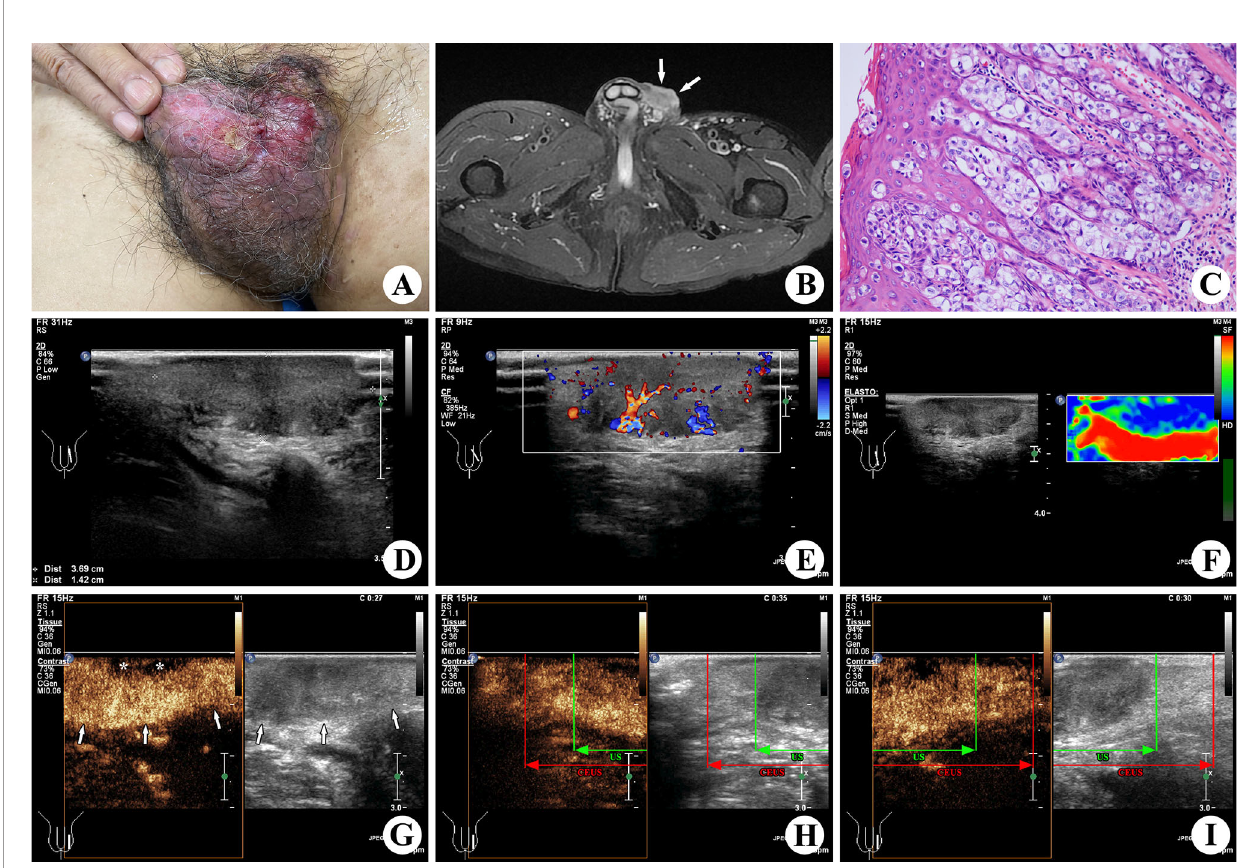
FIGURE 1 | A 67-year-old patient with EMPD. An ulcerative and eczematous lesion was shown on his left scrotum (A) . A lesion with irregular margin ( ↑ ) was found at his left scrotum in T2WI fat-suppressed sequences of MR (B) . Scattered epidermal Paget cells with a pleomorphic and hyperchromatic nucleus and abundant clear cytoplasm were located throughout the epidermis in nest-like structures in histopathologic examination of the excised specimen (×200; H&E stain) (C) . In the preoperative conventional US, a 3.6 × 2.9 × 1.4 cm lesion on the left side scrotal wall appeared to be hypoechogenicity, in fi ltrative margin, and presence of profuse vascularity (D, E) . Elastography showed blue color in and around the lesion, which was valued to be hard in a score of 4 (F) . The preoperative CEUS showed hyper- enhancement ( ↑ ) in the main part and non-enhancement (*) in the super fi cial area of the lesion (G) , which was larger than that shown in the conventional US. In the upper part of the lesion (H) , the green line represents the upper boundary con fi rmed by the conventional US, and the red line represents the upper boundary con fi rmed by CEUS. In the lower part of the lesion (I) , the green line represents the lower boundary con fi rmed by the conventional US, and the red line represents the lower boundary con fi rmed by